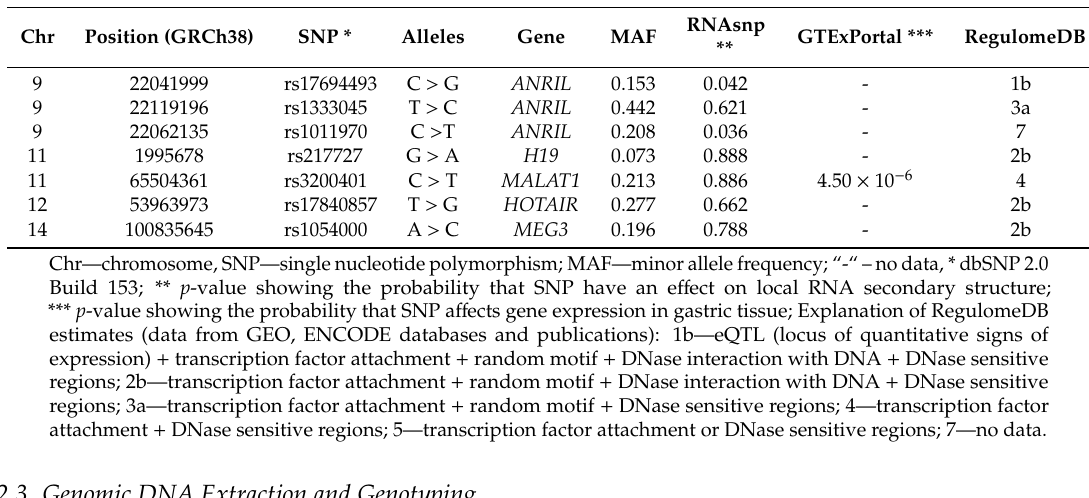
Table 1. Selection criteria of long non-coding RNA